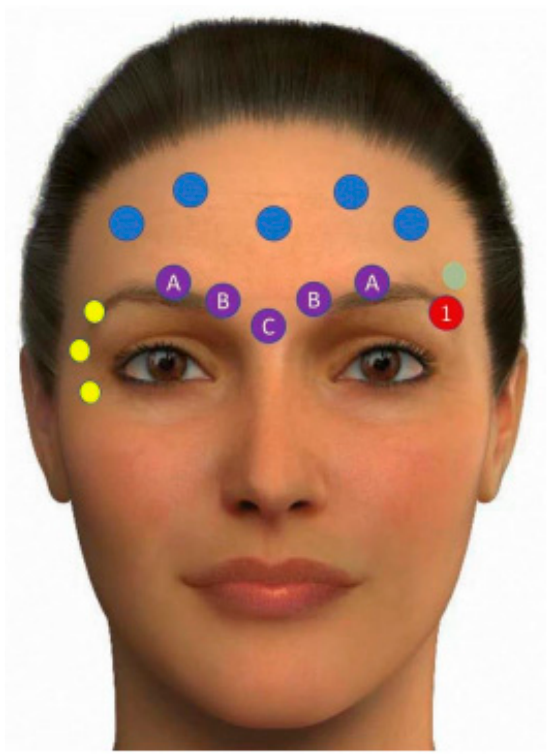
Figure 14. Different upper-face treatment points. The yellow circles show botulinum toxin A therapy for crow’s feet lines. Blue circles represent BTX therapy for forehead lines. The purple circles represent the treatment locations for glabellar lines with botulinum toxin A. The red circle denotes spot (1) for implanting low-density hyaluronic acid to raise the brow’s tail. The green circle represents the temporal area, which will be treated with a high-density hyaluronic acid implant (T1). A denotes one third of the needle depth to target depressor supercilii. B denotes full needle depth to target the corrugator supercilii. C represents one-half needle depth to target the procerus [61].